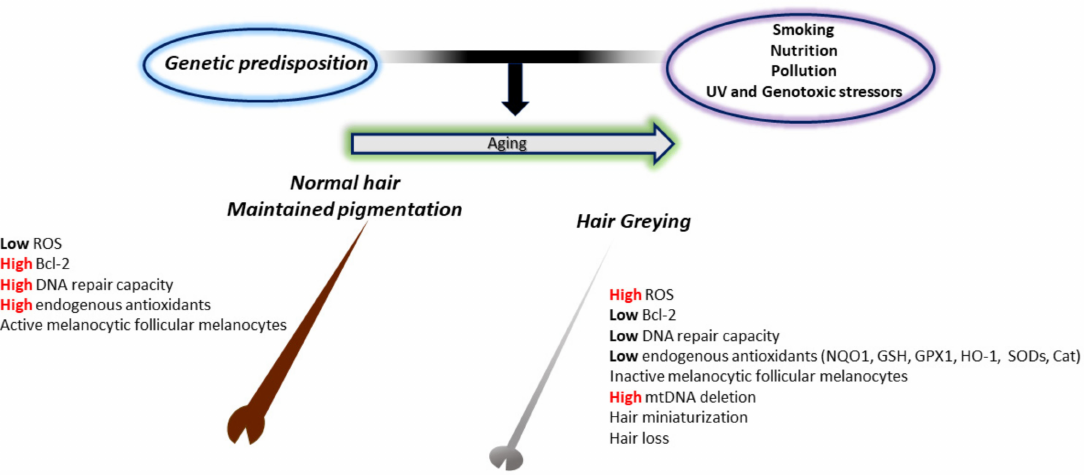
Figure 3. The involvement of oxidative stress in the greying process. In young and healthy subjects, melanocytes in pigmented hair follicles can deal with the low endogenous oxidative stress caused by the melanin biosynthetic pathway. This is due to the adequate presence of endogenous antioxidant levels and the high DNA repair activity. In old subjects, however, reduced production of endogenous antioxidants and repair enzymes induce deleterious oxidative stress damage in pigment-producing cells. This results in the accumulation of senescent inactive melanocytes around the dermal papilla and at the outer root sheath, no melanocyte stem cells at the bulge area, and consequent a non- pigmented hair